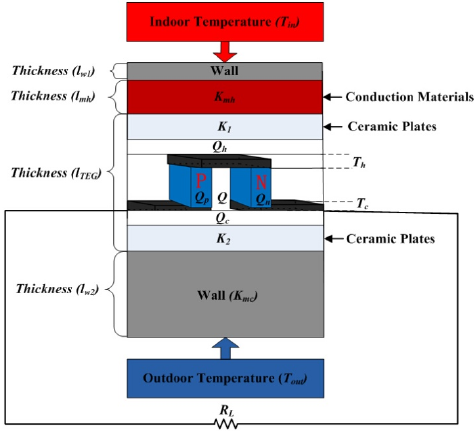
Figure 1. The schematic of the fundamental unit of a TE module embedded in a board with a thermally conductive material.